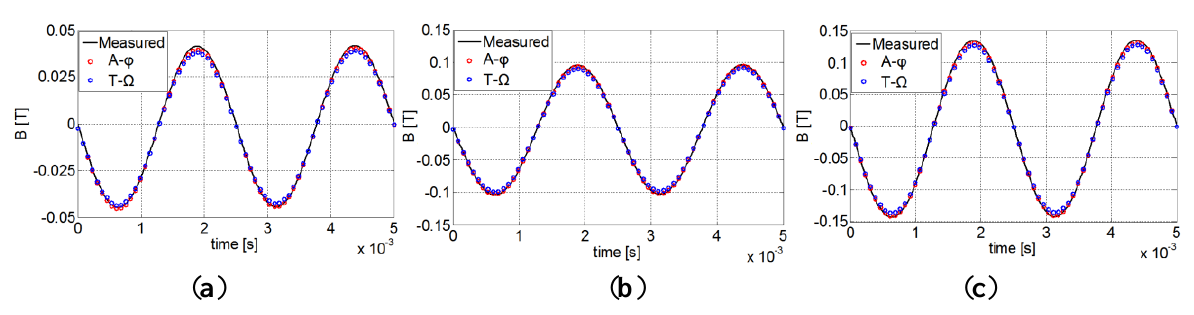
Figure 8. Magnetic flux density in the magnet for: ( a ) ΔB ≈ 0.1 T, ( b ) ΔB ≈ 0.2 T and ( c ) ΔB ≈ 0.3 T.